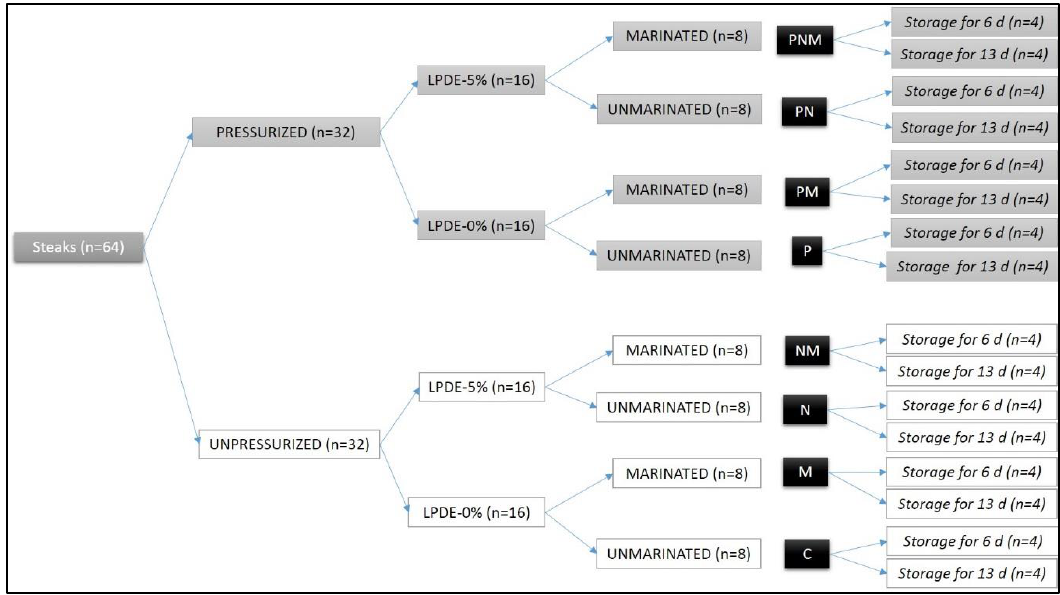
Figure 1. Experimental design.